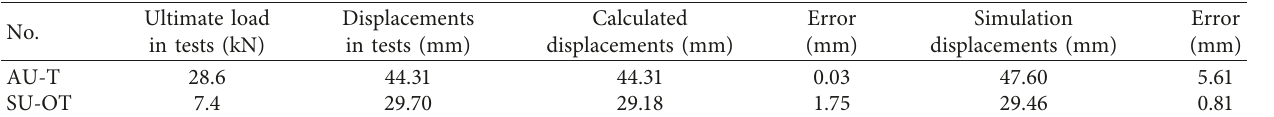
Table 1: Comparison of displacement at midspan between calculation and test or